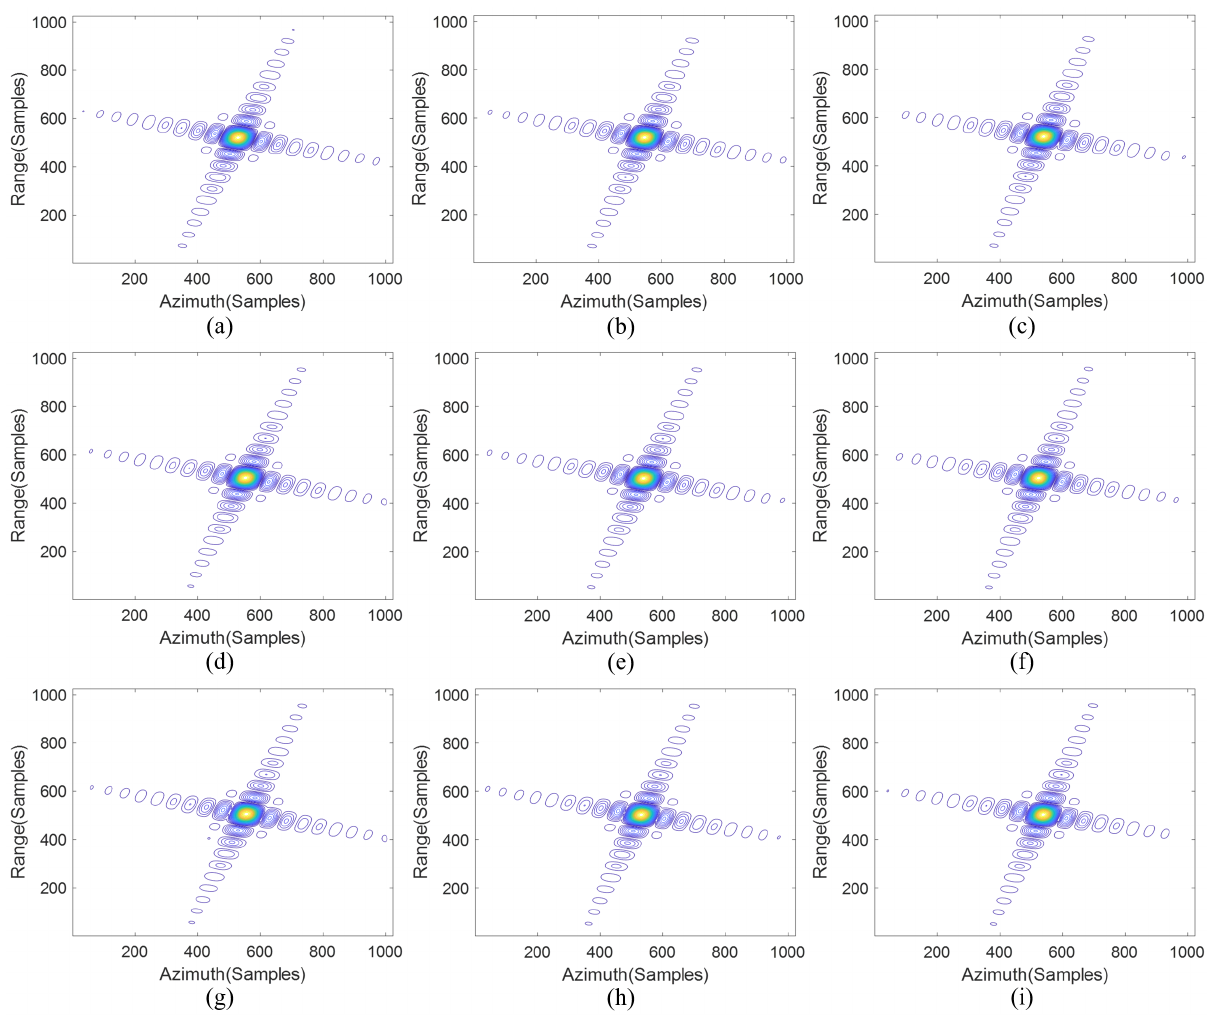
Figure 7. Real-time imaging results of the proposed method. ( a – c ) Results of targets 1–3. ( d – f ) Results of targets 4–6. ( g – i ) Results of targets